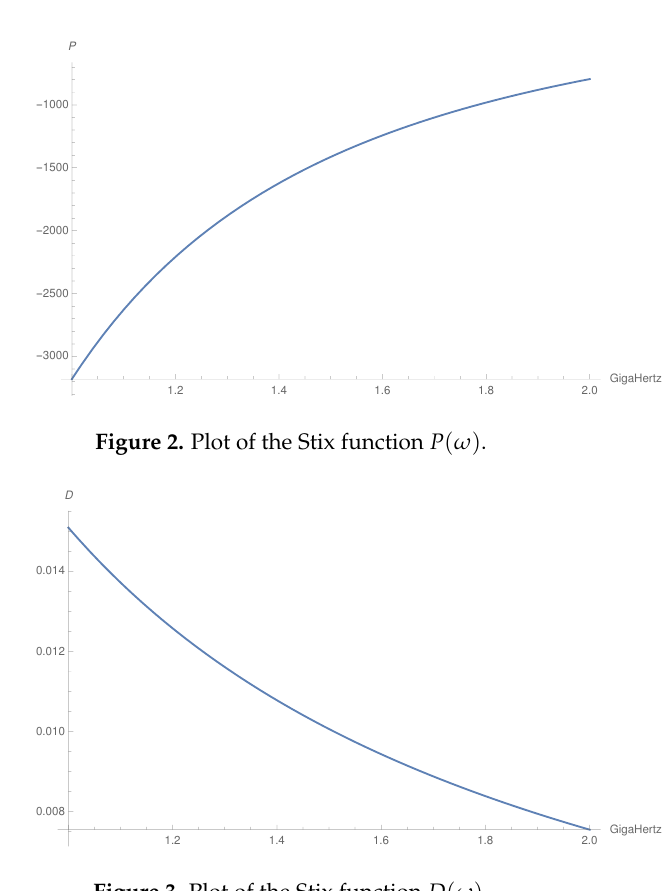
Figure 3. Plot of the Stix function D ( ω )